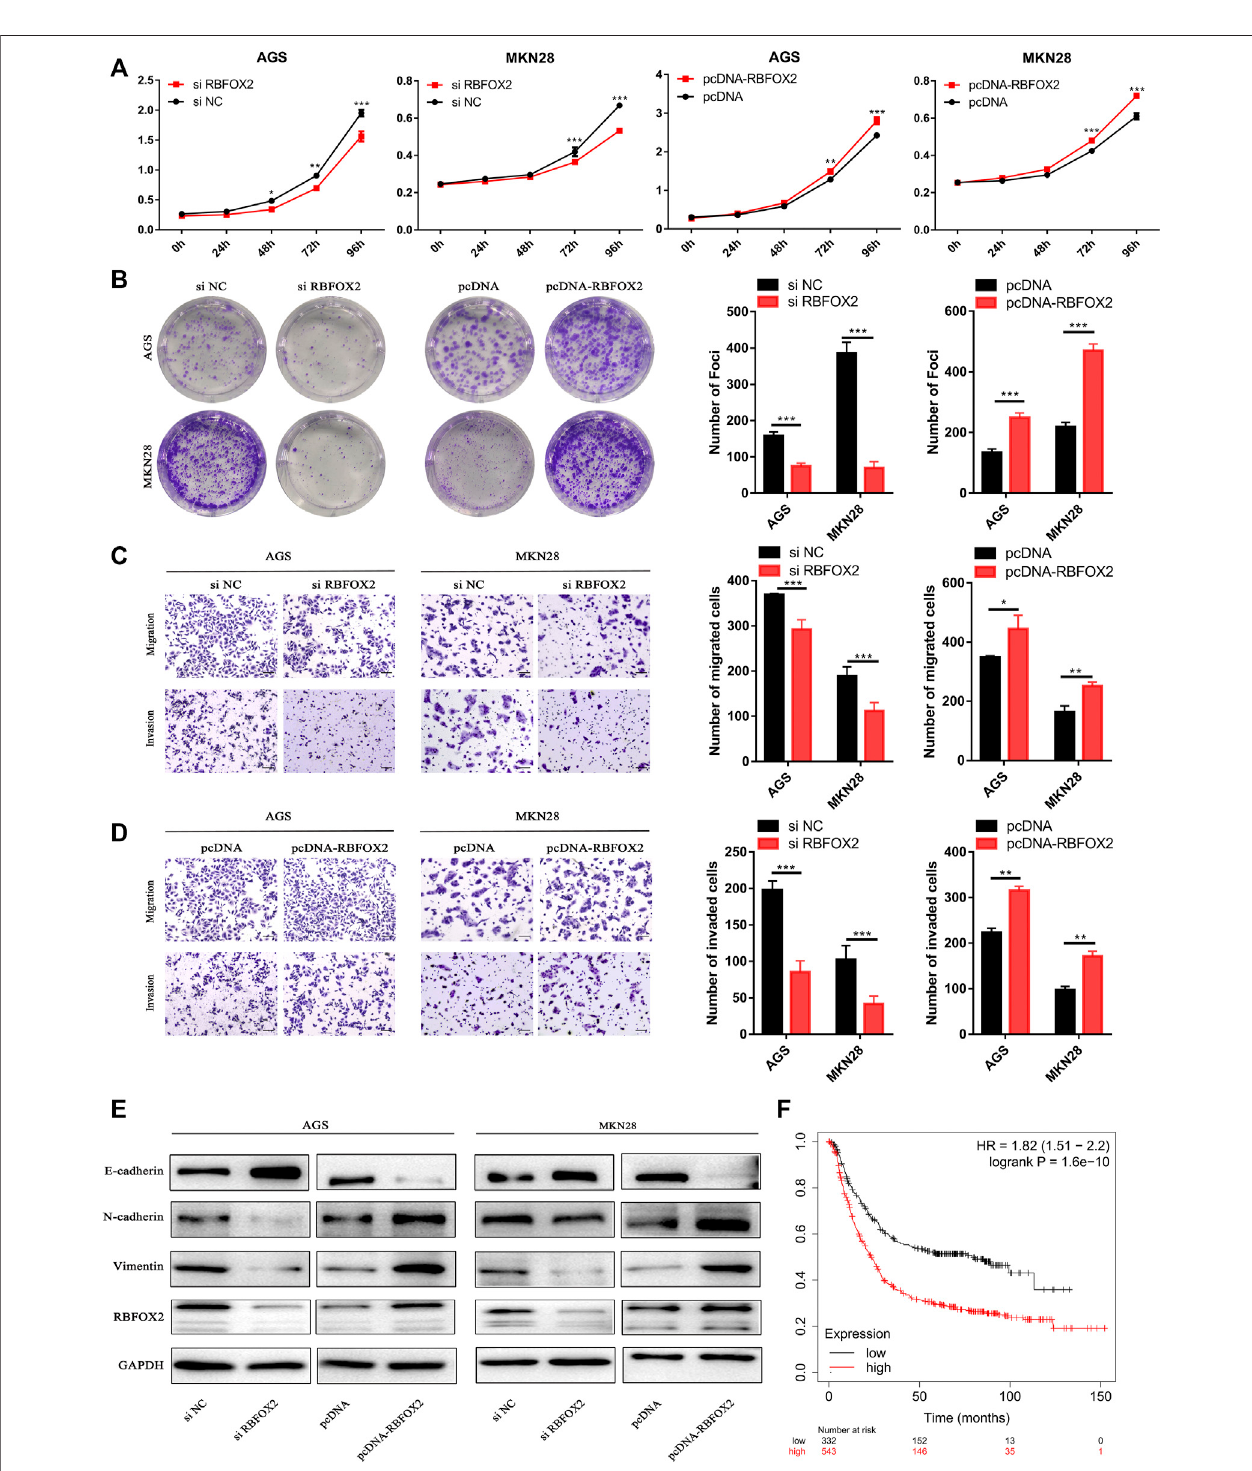
FIGURE 6 | RBFOX2 promotes malignant behavior and EMT in GC cells in vitro (A,B) The effects of RBFOX2 knockdown or overexpression on proliferation and platecolony-formingabilityweremeasuredinGCcells (C,D) TheeffectsofRBFOX2knockdownoroverexpressiononmigrationandinvasionweredetected (E) Relative expression of E-cadherin, N-cadherin and Vimentin was detected by western blotting in gastric cancer cells after RBFOX2 were either knocked down or overexpressed (F) Survival rates analysis of between RBFOX2 and GC were analyzed by KM Plotter database (https://kmplot.com). * p < 0.05, ** p < 0.01, *** p < 0.001.